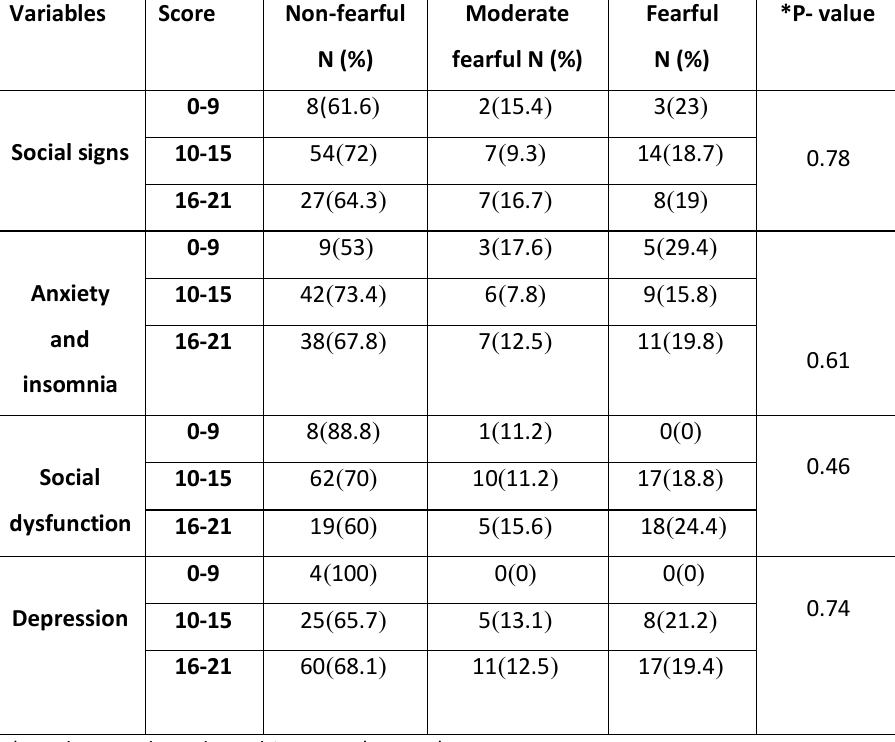
Table 2. Frequency distribution of parental general health by children ' s dental fear